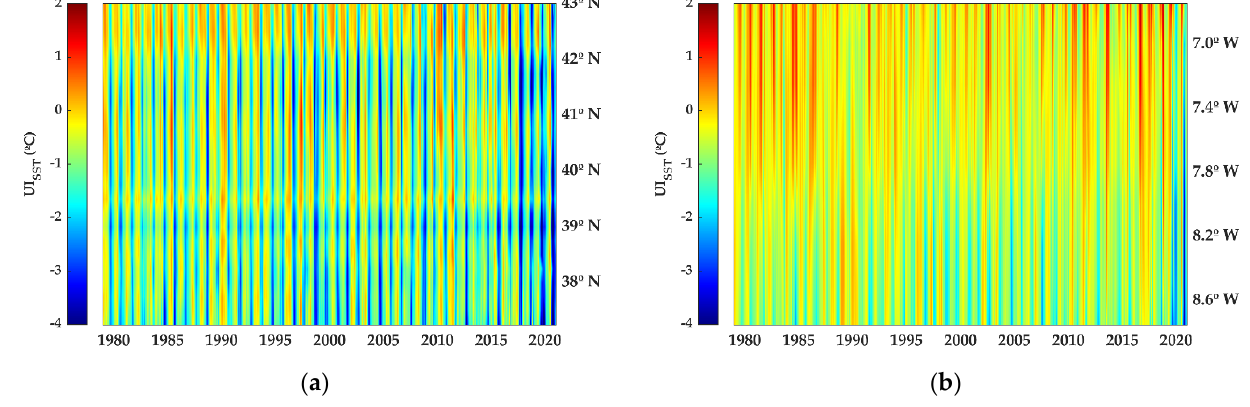
Figure 6. Evolution of UI SST (°C) over the period 1979–2020 on the Portuguese ( a ) west coast and ( b ) south coast.